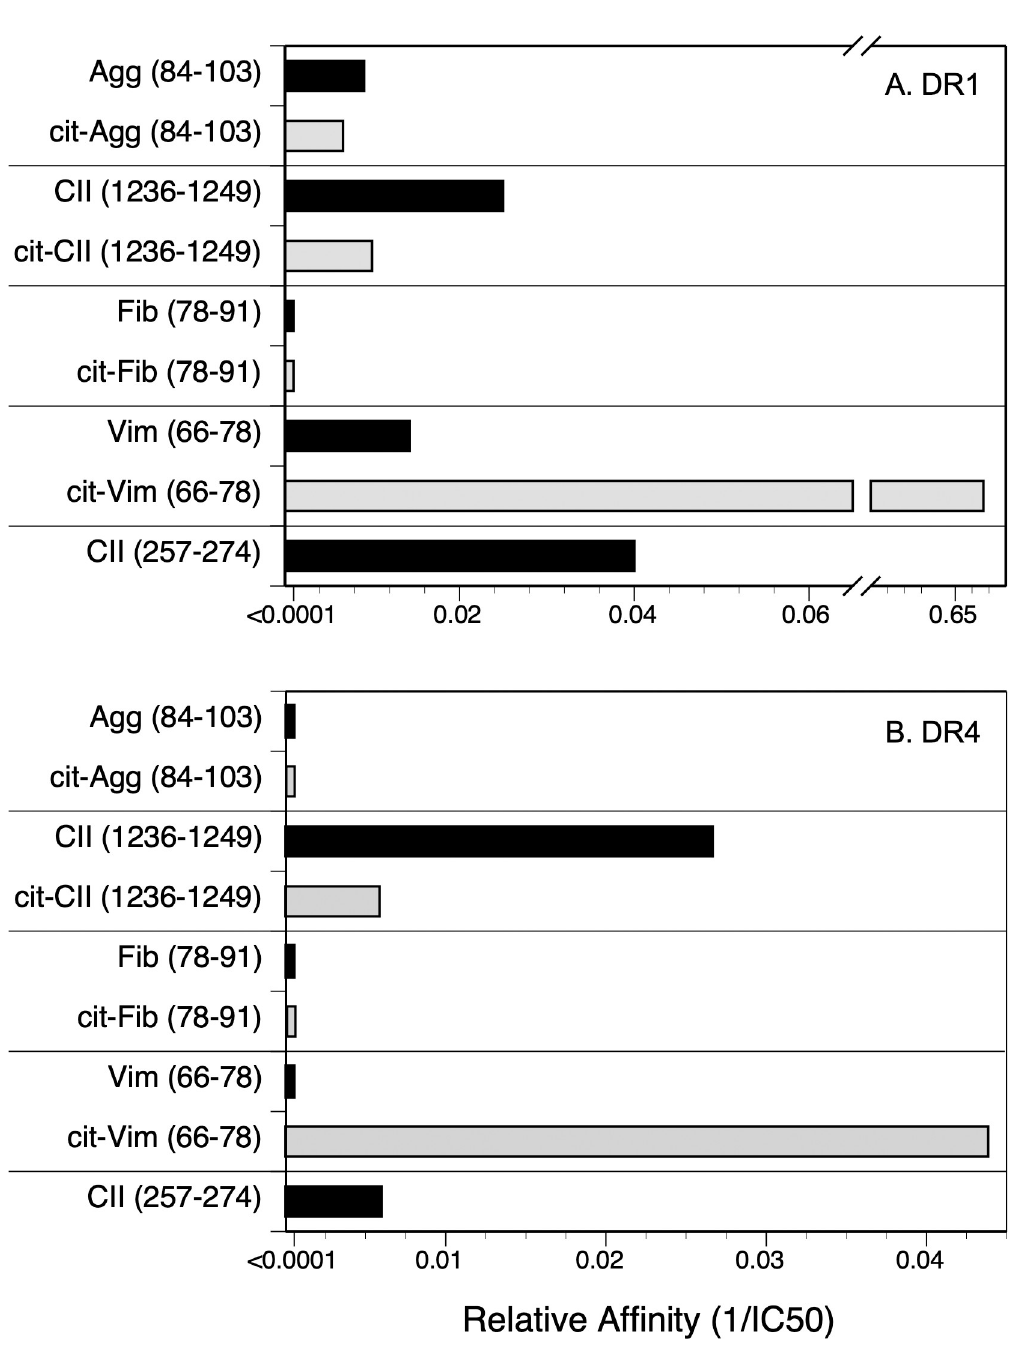
Fig 3. Relative affinity of WT and Cit-peptide binding to DRB1 � 01:01 and DRB1 � 04:01. The 50% inhibitory concentration values (IC 50 ) values were calculated from the binding curves in Figs 1 and 2, and plotted as 1/IC 50 to indicate relative affinity. Panel A, DR1 binding; panel B, DR4